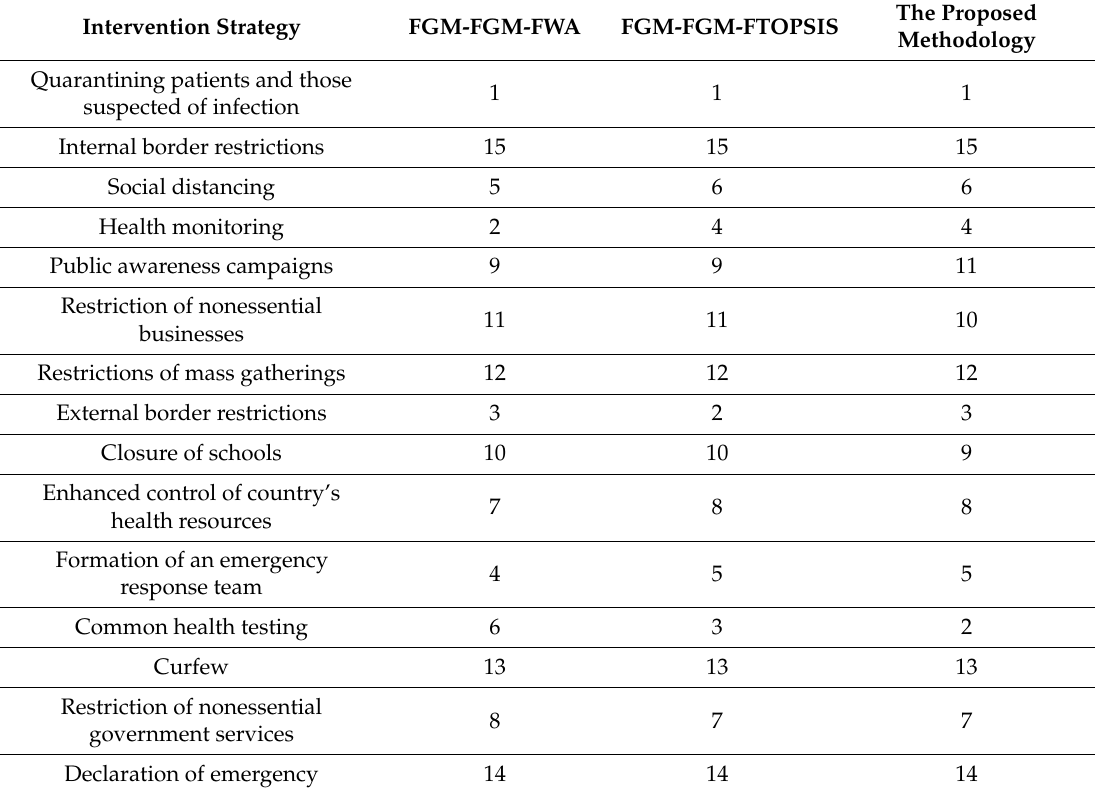
Table 9. Ranking results using various